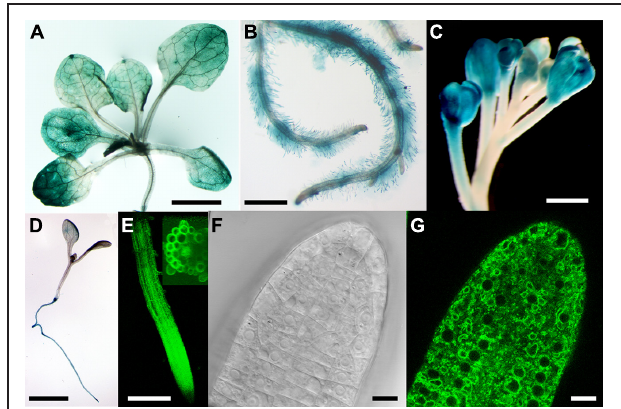
FIGURE 1 | Tissue expression pattern of CATIONIC AMINO ACID TRANSPORTER ( CAT9 ). Histochemical glucuronidase (GUS) analysis from the shoots of a 25-days-old seedling expressing the p CAT9::GUS construct (A) and roots (B) . Staining of flowers (C) and of a 4-days old seedling (D) . (E) Fluorescence from 10-days old seedling roots expressing pCAT9::CAT9–GFP; inset: 40-stacks-sectioned fluorescence). (F,G) Bright field and fluorescence image of a pCAT9::CAT9–GFP expressing root tip. Scaling bars: (A , B , D) : 0, 5 cm, (C,E) : 250 μ m, (F,G) : 20 μ m.